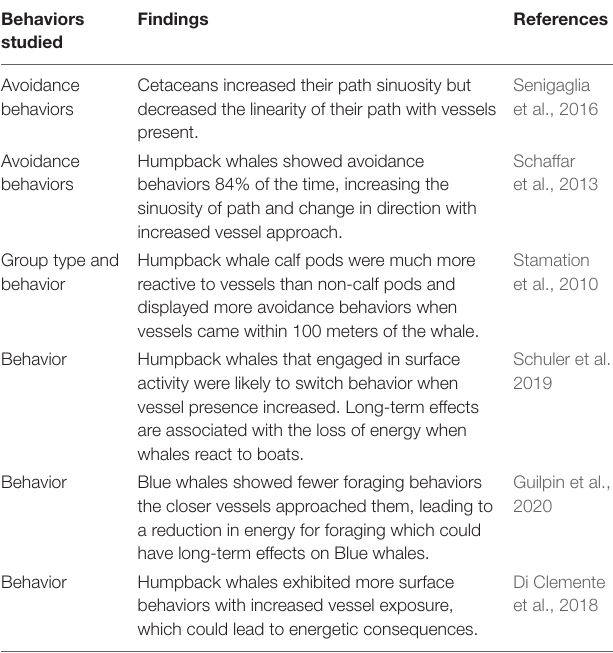
TABLE 2 | Categories of behaviors used in this study from prior studies on the impacts of whale watching on orcas and humpback whale